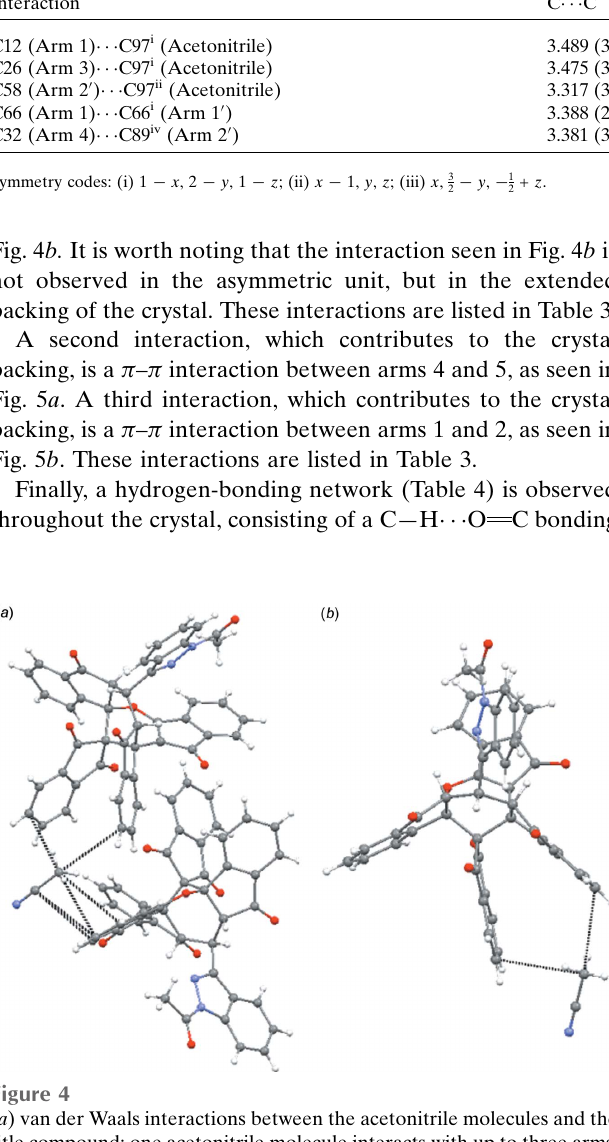
Table 3 Packing interactions found inside the crystal lattice (A˚ ). Shortest bond distances that were found are shown for the various interactions. Interaction